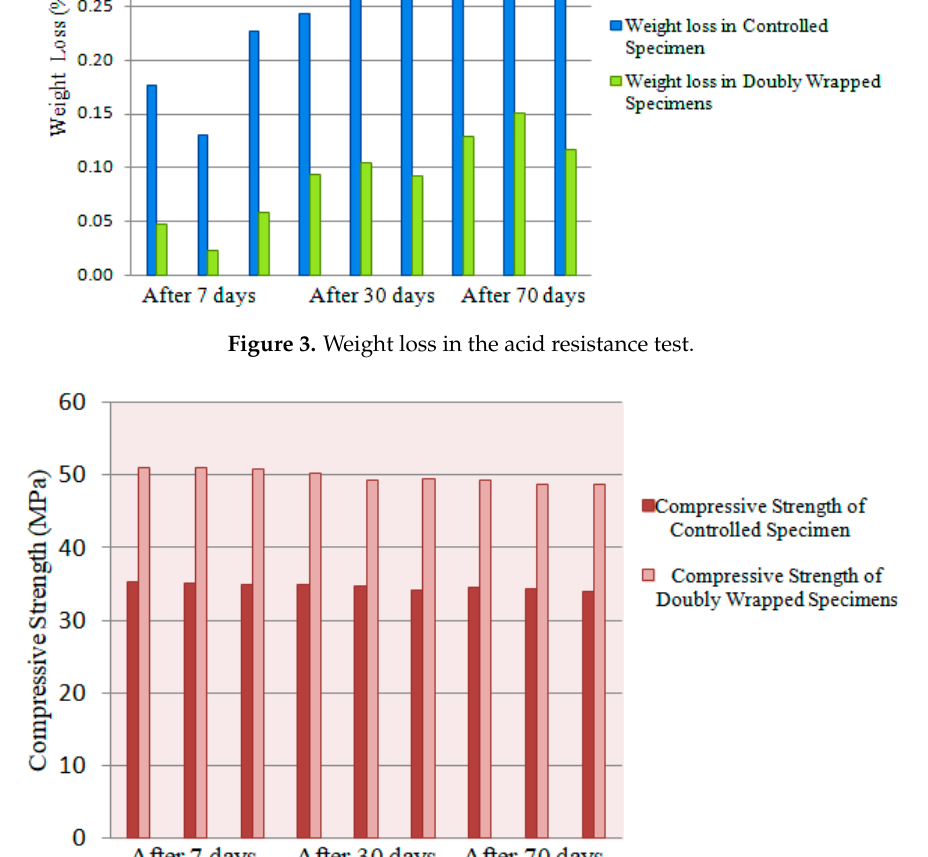
Figure 4. Compressive strength in the acid resistance test.